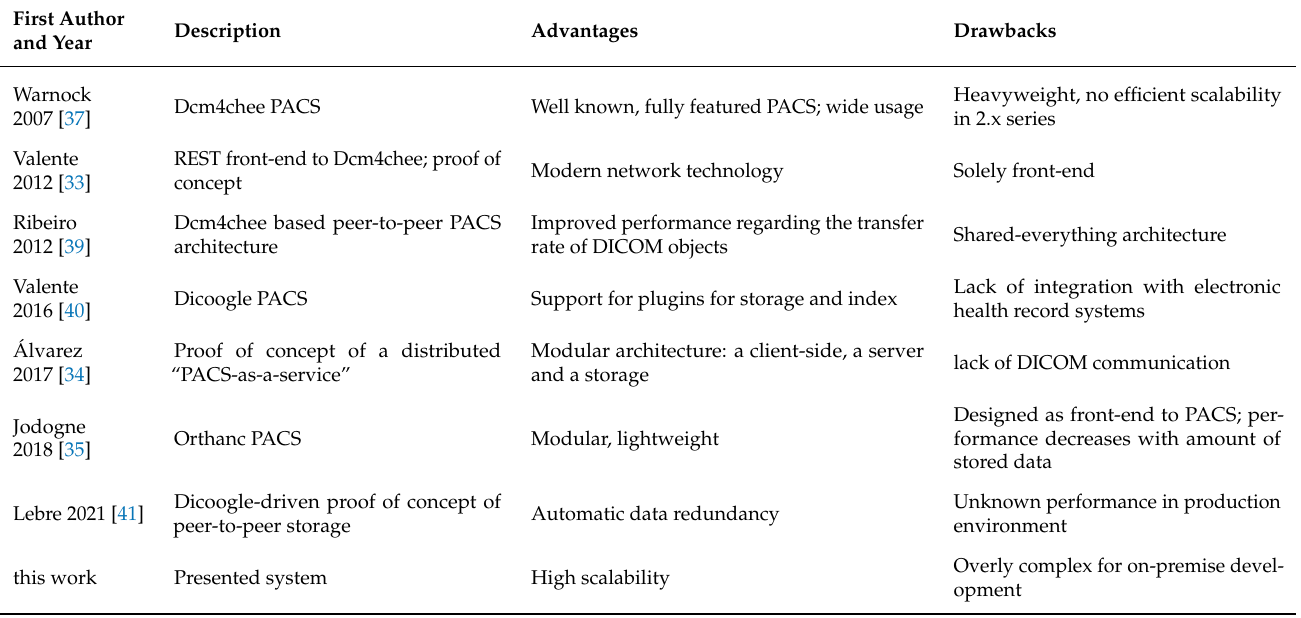
Table 1. Comparison of various PACS